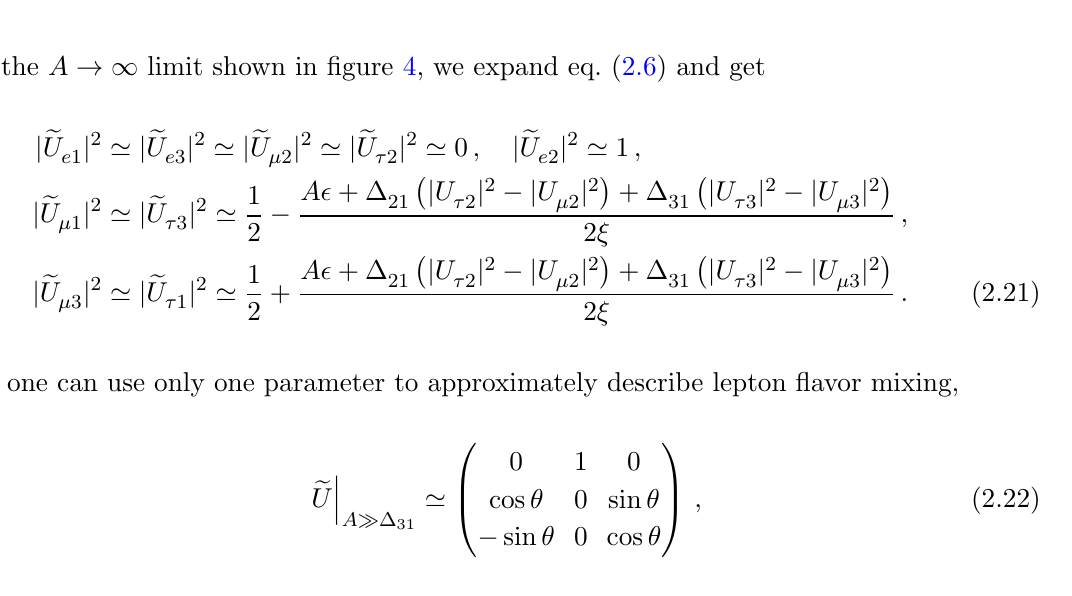
Figure 4 . In the standard three-(cid:13)avor mixing scheme, the illustration of how e; (cid:22); (cid:28) and i = 1 ; 2 ; 3) evolve with the matter e(cid:11)ect parameter A in the case (IMO ; (cid:23) ) with or without radiative corrections, where the best-(cid:12)t values of ( (cid:18) have been